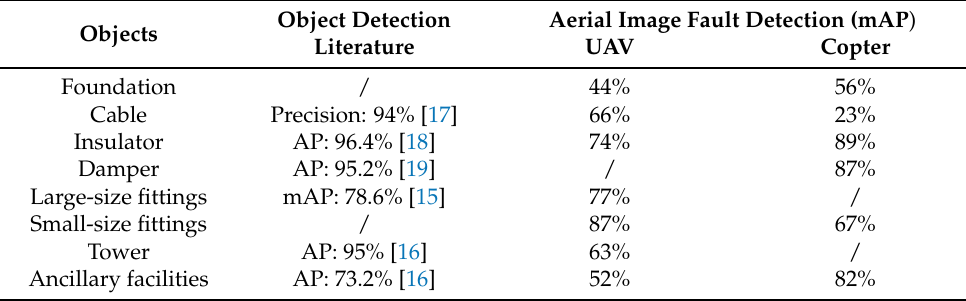
Table 1. The developments of visual detection studies on tower inspection aerial